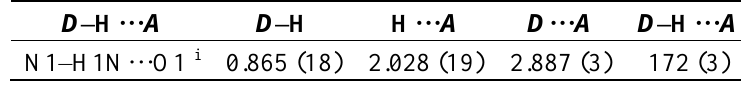
Figure 4. Chain of molecules linked by hydrogen bonding and spreading along the screw 2 1 axis, parallel to the b axis (½ y ¼). Table 3. Hydrogen bond geometry (Å,